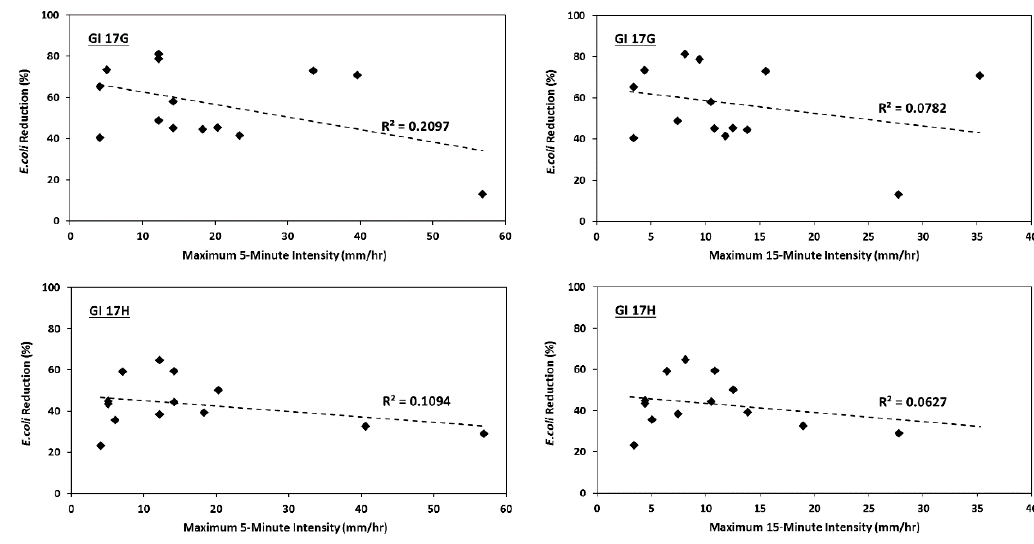
Figure 9. E. coli reduction percentages versus maximum 5- and 15-min intensity values.